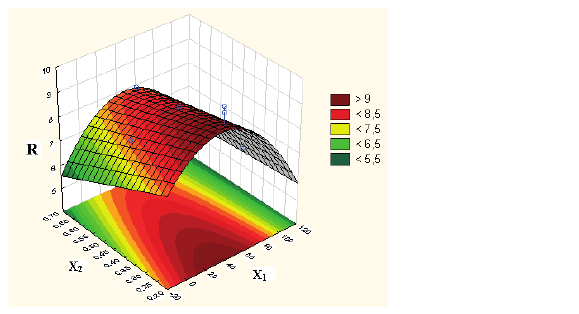
Fig. 6. The response surface of the dependence of the strength of magnesia composites on the composition of the moulding